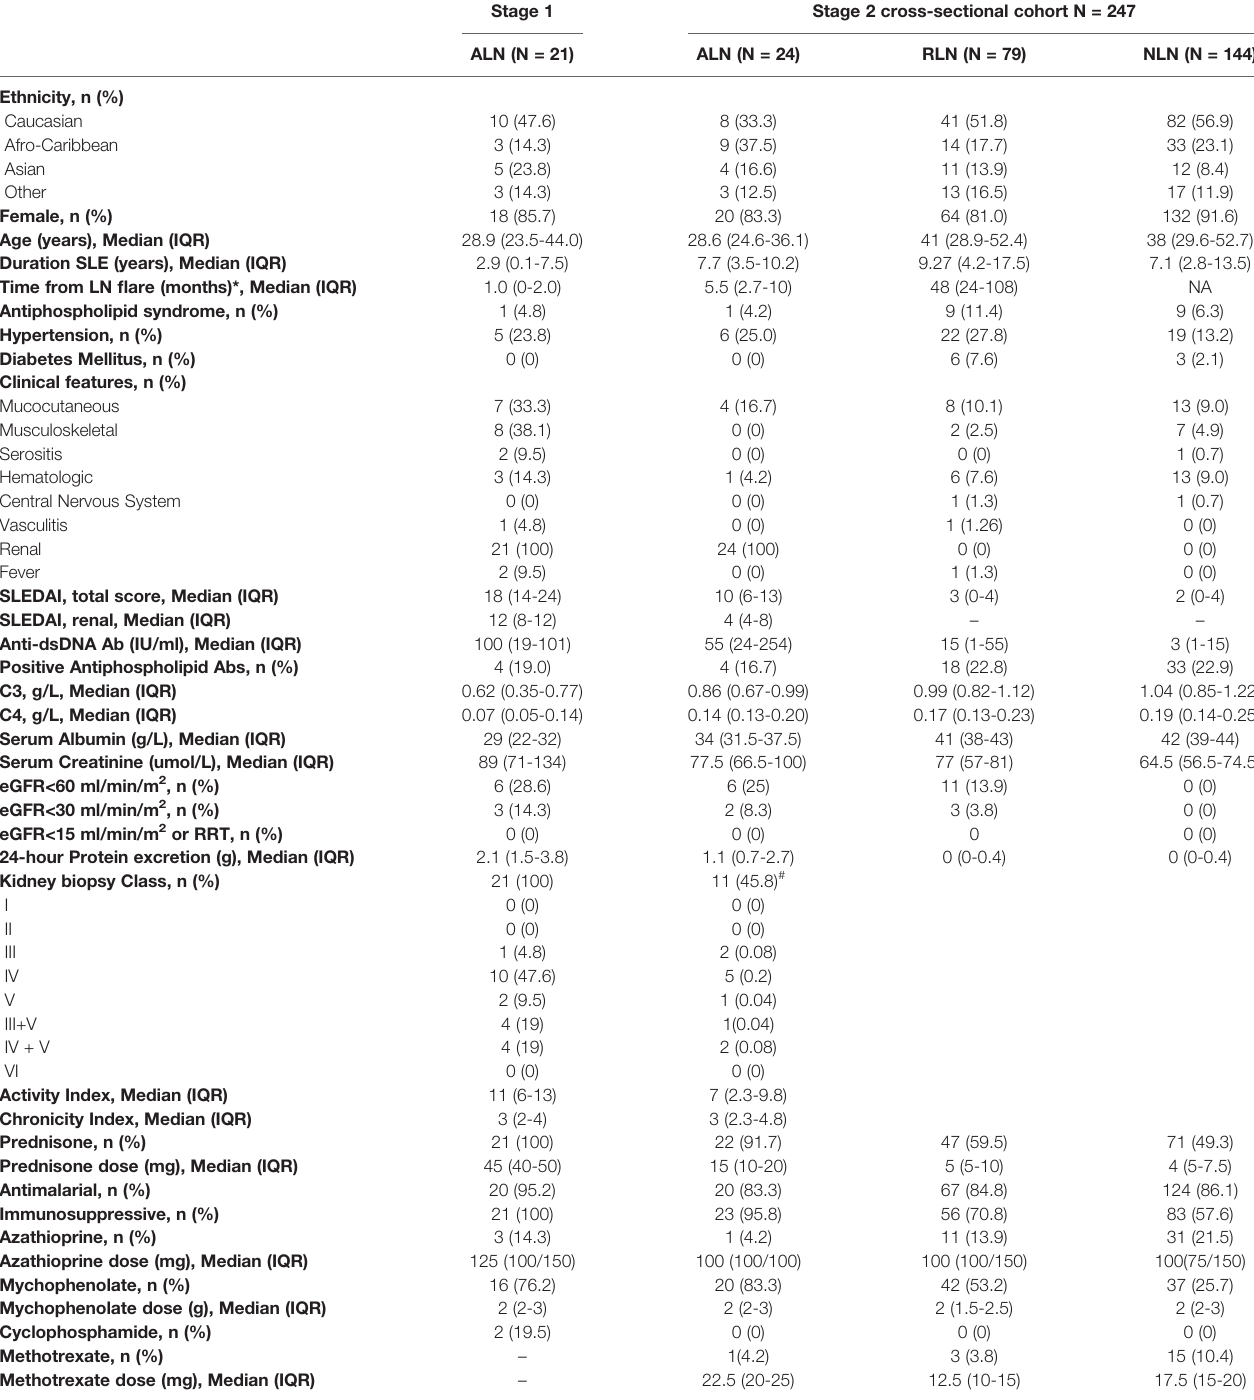
† Baselineclinicalcharacteristics areatthetimeoftheurinesamplecollection,*TimefromLN fl aretourinesamplecollection(months), # Remaining13patientsdidnothaveaKBatthetime of the urine sample collection, of whom 3 did not have a prior KB and 10 had a prior KB (9 class III or IV with or without class V and 1 pure class V). eGFR, estimated Glomerular Filtration Rate, RRT, Renal Replacement